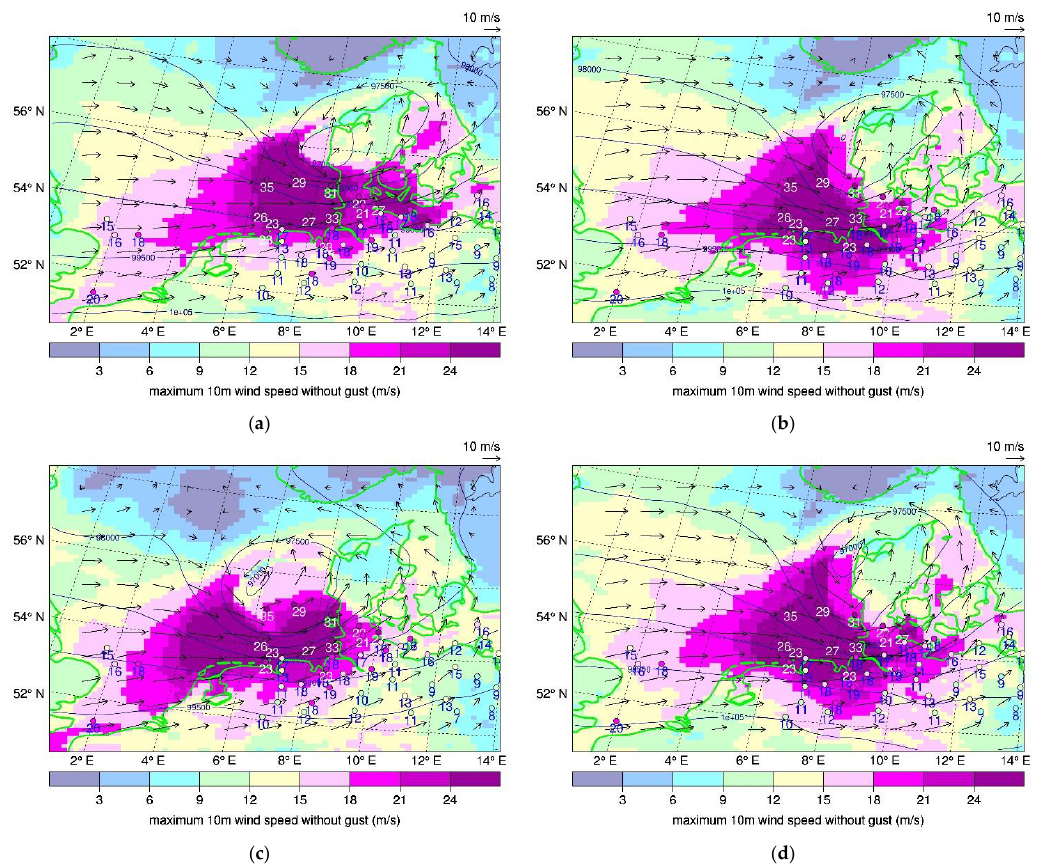
Figure 10. Mean sea level pressure MSLP ((Pa), contours) and 10-m wind ((m/s), shaded and vector) of ( a ) CCLM_sn, ( b ) CPL0, ( c ) CCLM1 and ( d ) CCLM4 at 14 UTC on 28 October 2013. The numbers show observations of GTS, MyOcean and FONA3 data.